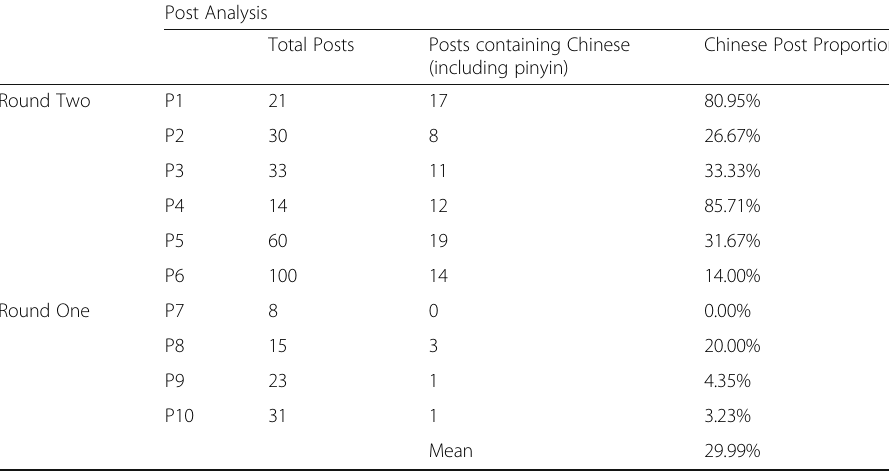
Table 6 The Chinese Posts